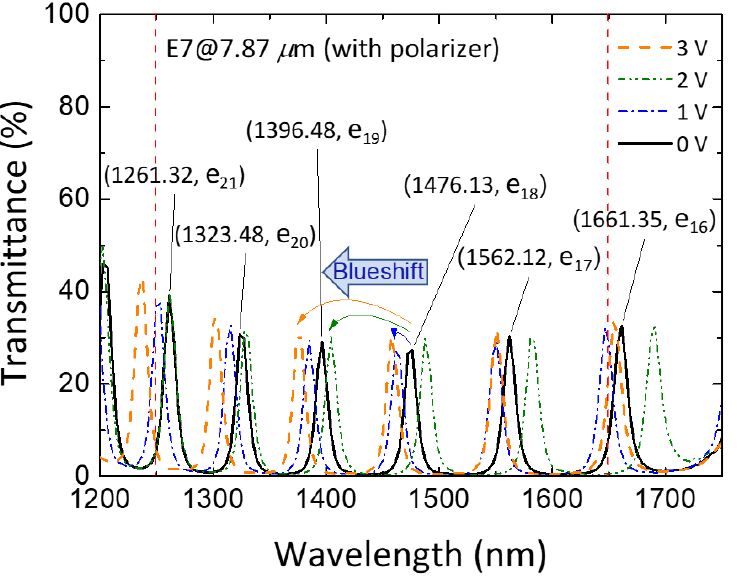
Figure 7. Polarized transmission spectra of the 7.87 µ m thick PC/LC cell at V = 0 V rms , 1 V rms , 2 V rms , and 3 V rms